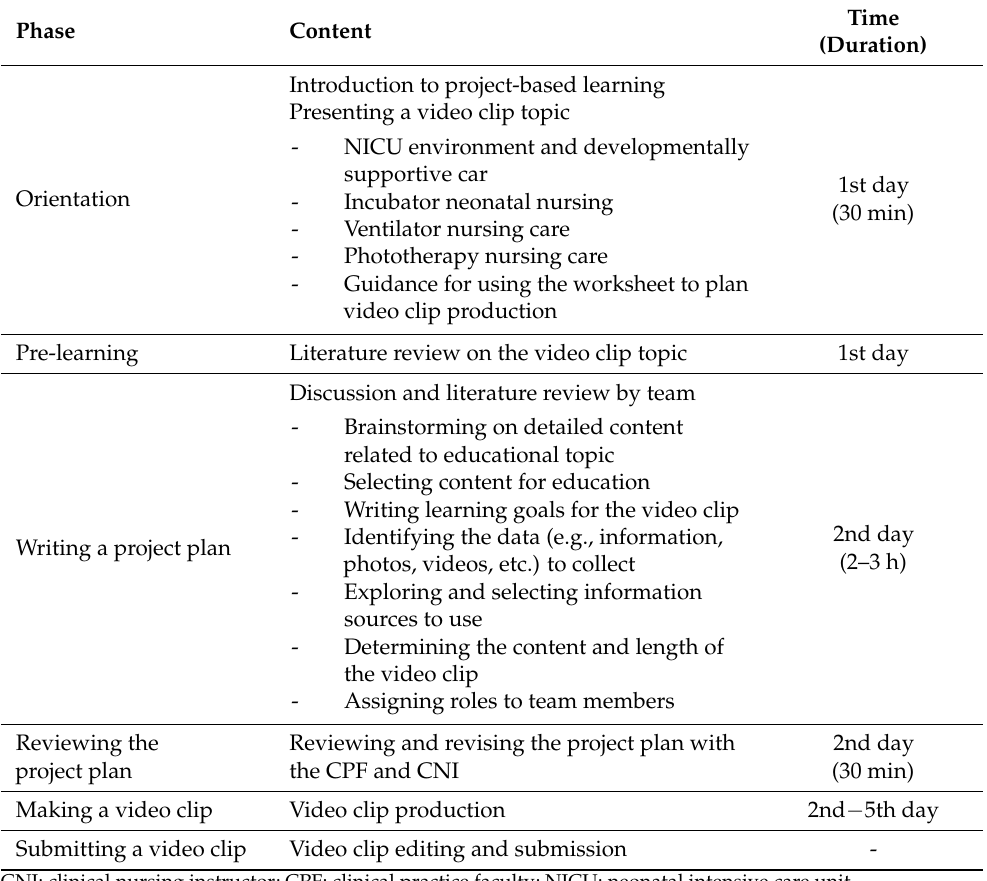
Table 1. Project-based learning for high-risk newborn care for nursing